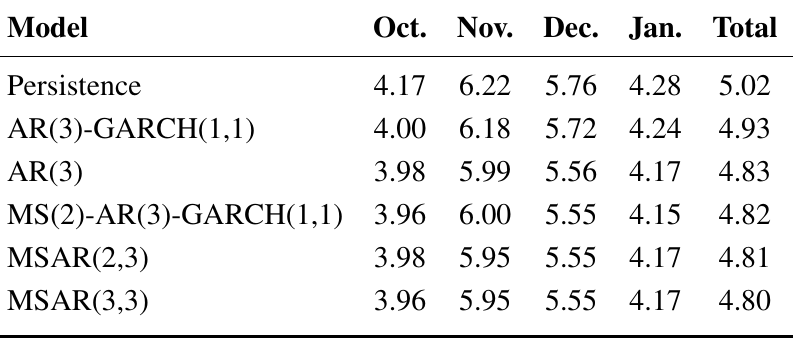
Table 5. NRMSE score given in percentage of the nominal capacity of the Horns Rev 1 wind farm. Results are given for the same models as for the